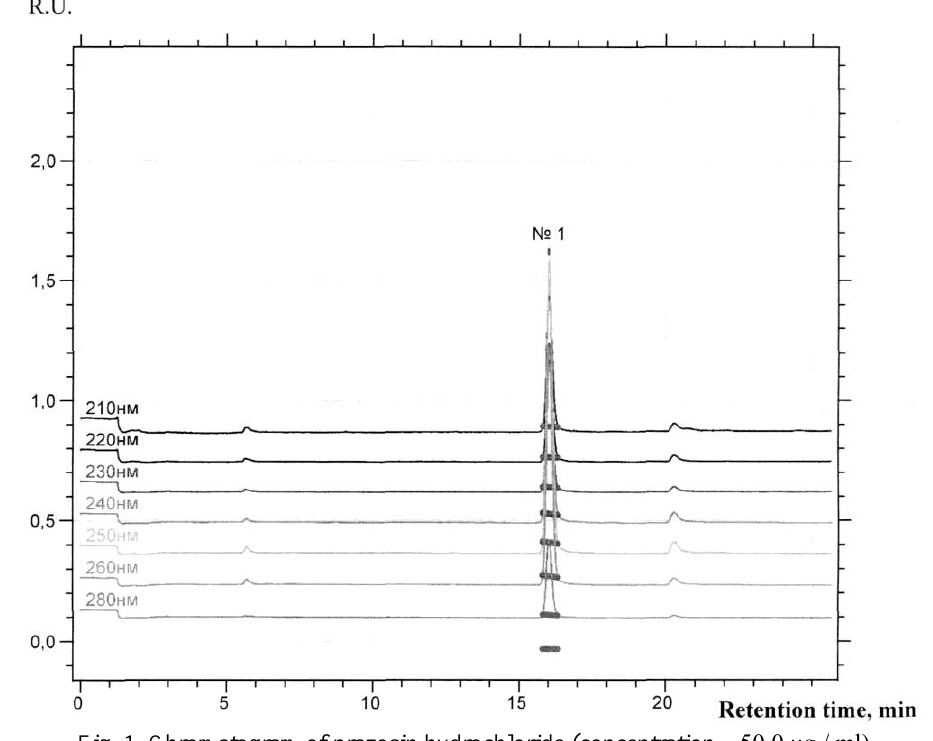
Fig. 1. Chromatogram of prazosin hydrochloride (concentration – 50.0 μg /